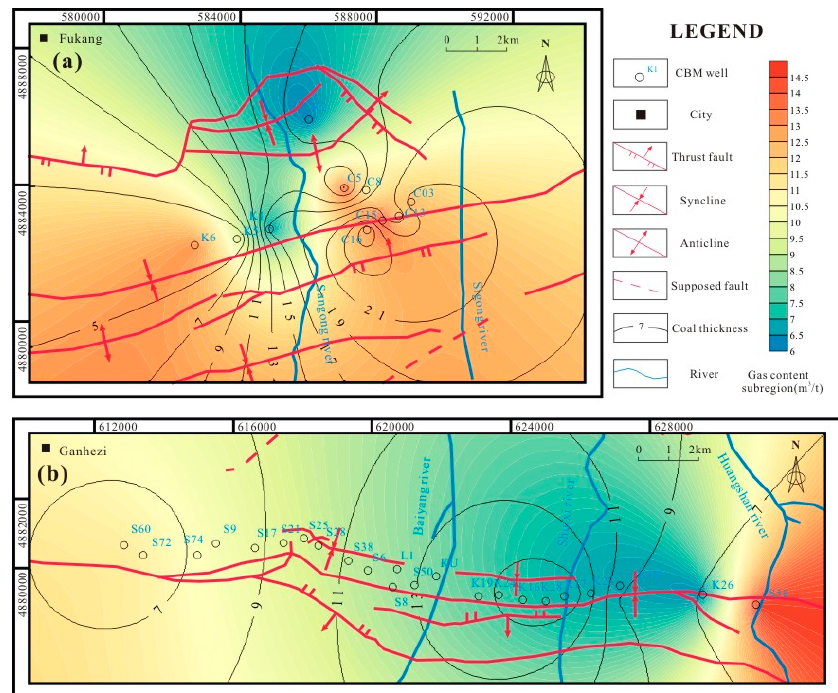
Figure 9. Relationship between gas content and coal thickness of No. 43 coal seam in the Fukang syncline ( a ) and Ergonghe syncline ( b ) (units of contour lines: m for coal thickness and m 3 /t for gas content with different color areas).